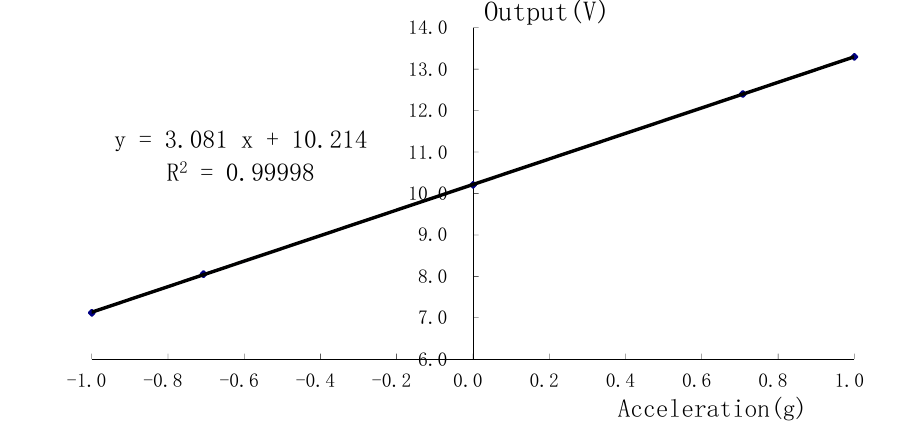
Figure 14. Curve of the output data vs. input data. Table 4. Datum of the static gravitational field roll test.